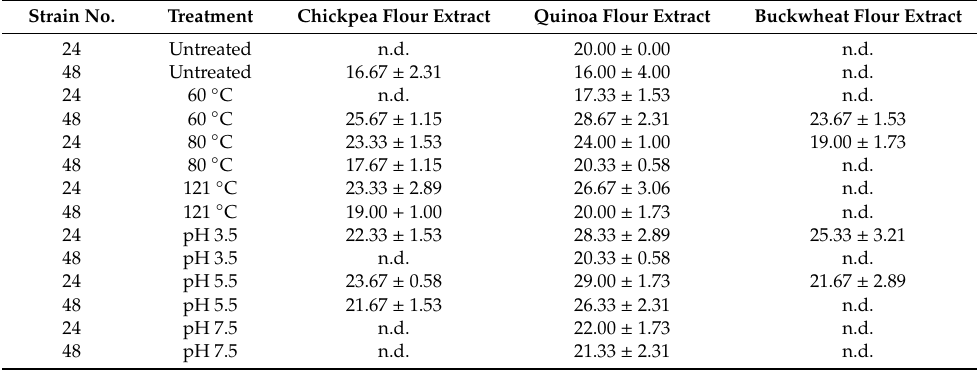
Table 5. Antibacterial activity of the fermented flour extracts undergoing thermal and acidification treatments. The fermentations were carried out throughout 72 h at 37 ◦ C with Lactobacillus spp. no. 24 and Leuconostoc spp. no. 48. The values are presented as average values of three ( n = 3) replicates ± standard